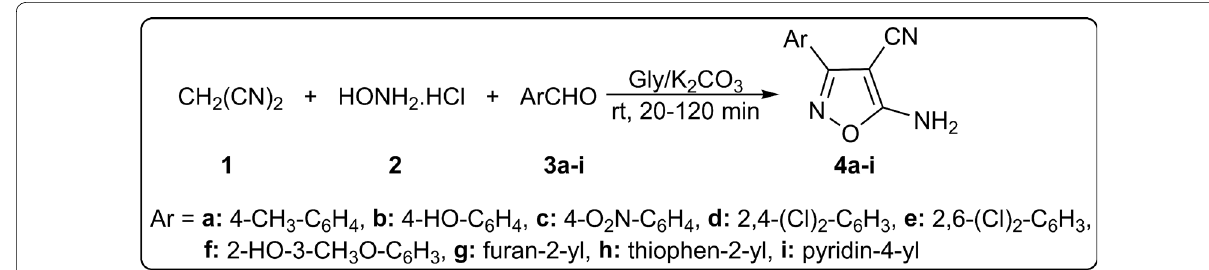
Scheme 1 Multicomponent synthesis of